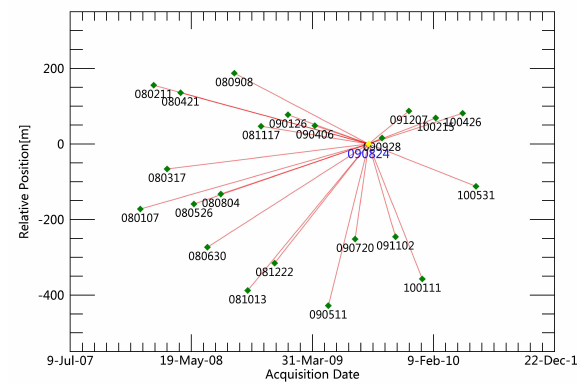
Figure 4.The spatio-temporal baseline of 23 Envisat interferometric pairs